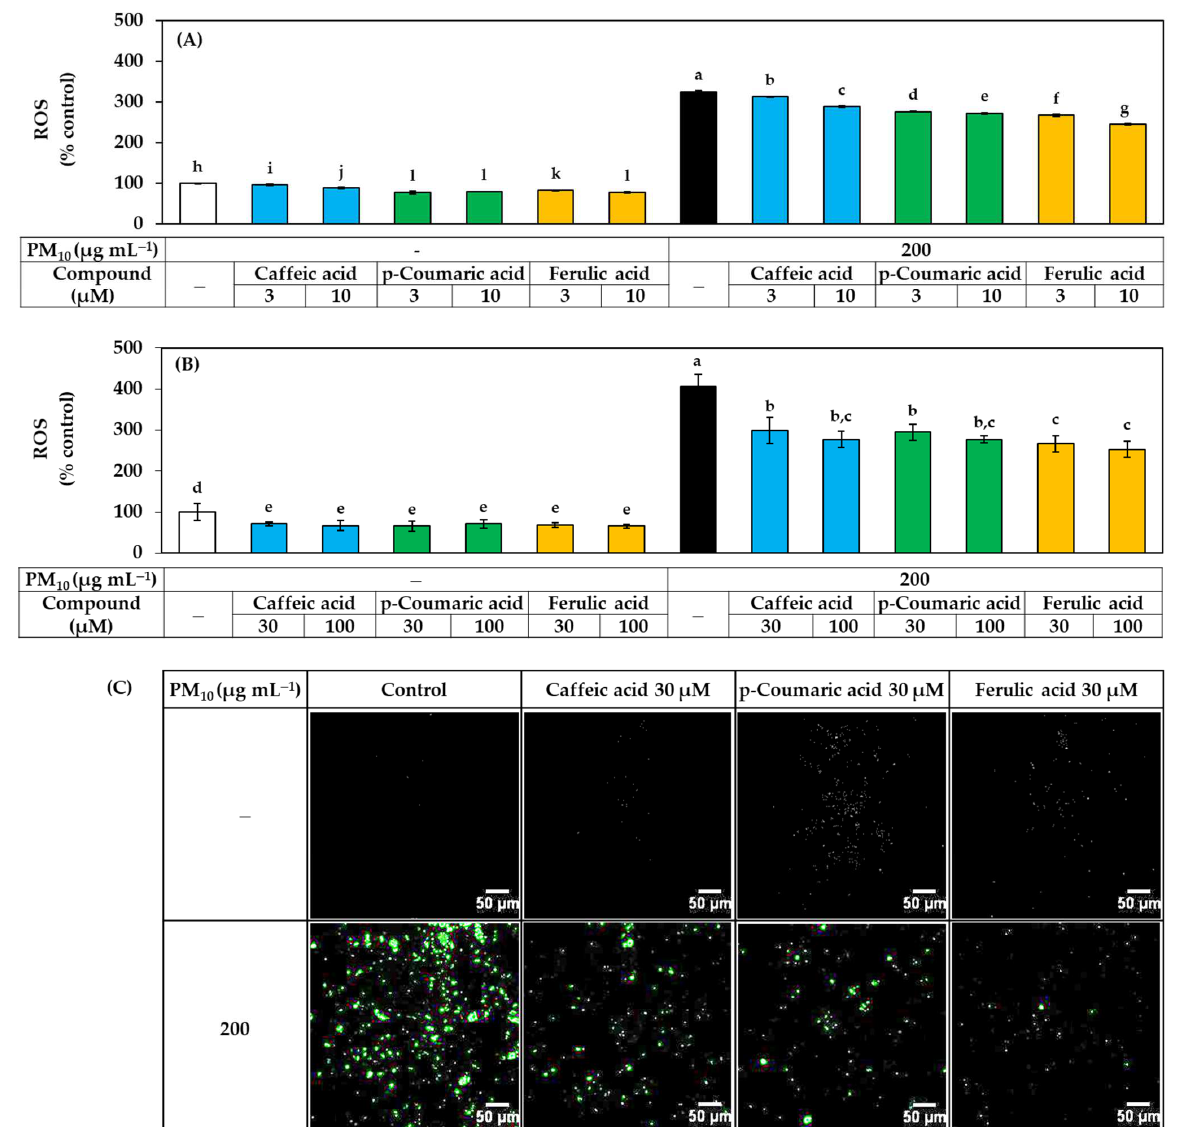
Figure 6. Effects of caffeic acid, p- coumaric acid, and ferulic acid on the ROS production in HaCaT keratinocytes exposed to PM 10 . Cells were labeled with DCFH-DA, treated with each compound at the indicated concentrations, and exposed to PM 10 (200 μg mL −1 ) for 60 min or not. In ( A , B ), the fluorescence of the cell extracts was measured to quantitatively determine ROS levels. Data are presented as mean ± SD ( n = 4). Duncan’s multiple range test was performed to compare all